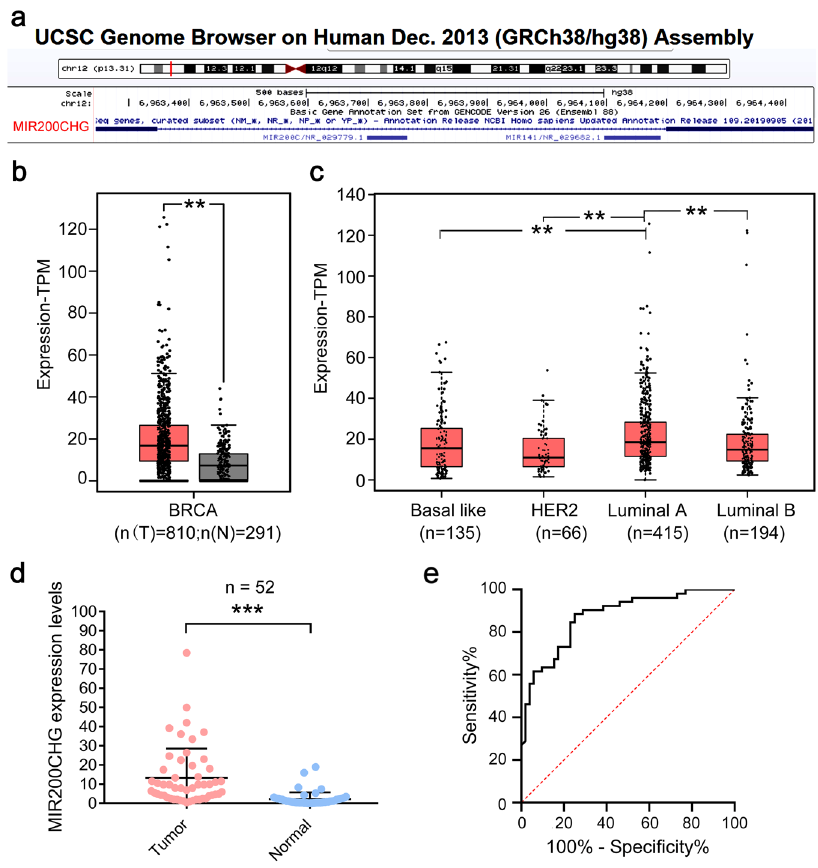
Fig. 1 MIR200CHG is upregulated in breast cancer tissues. a Gene structure of MIR200CHG. b , c The expression of MIR200CHG in breast cancer and its subtypes in The Cancer Genome Atlas was analyzed by GEPIA2. N, non-tumor tissue, gray. T, tumor tissue, red. ** P < 0.01. Boxplots represent medians (center line) and interquartile range (IQR; box), and whiskers represent the maximum and minimum values within 1.5 times the IQR from the edge of the box. d qRT-PCR was used to analyze the expression level of MIR200CHG in breast cancer tissues and adjacent non-tumor tissues, n = 52. GAPDH was used as an internal control. Dot plot of the individual data points, with a horizontal line at the arithmetic mean and error bars showing plus and minus one standard deviation. The data were analyzed by two-tailed unpaired T test. *** P < 0.001. e Receiver operating characteristic curve analysis based on the level of MIR200CHG in 52 analyzed breast cancer MIR200CHG increase the proliferation of MDA-MB-231 cells (Fig. 2e, f). Colony formation experiments con fi rm that compared with the control group, knockdown of MIR200CHG reduce the MCF7 cell colony formation rate to 8.62%, while overexpression of MIR200CHG increase the rate of MDA-MB-231 cell colony formation to 176.17% (Fig. 2g, Supplementary Fig. 2a). Flow cytometry analysis show that compared with the negative control group, the cell cycle distribution of MCF7-sh and MDA-231-exp does not change signi fi cantly (Fig. 2h, i, Supplementary Fig. 2b). Apoptosis analysis shows that knockdown of MIR200CHG increased the apoptosis rate in MCF7 cells, while overexpression of MIR200CHG does not signi fi cantly change the apoptosis rate in MDA-MB-231 cells (Fig. 2j, Supplementary Fig. 2c). Wound healing experiments show that the average open wound area of MCF7-sh cells (incubated for 20 h) is about 72.1%, and that of negative control cells is about 24.2%. The average open wound area of MDA-231-exp cells (incubated for 6 h) is about 44.2%, and that of the negative control cells is about 91.0% (Fig. 2k, l, Supplementary Fig. 2d). In the cell invasion experiments, the number of MCF7-sh cells passing through the Matrigel pores is 32.5% of the negative control group, while the number of MDA-231-exp cells reaches 365.8% (Fig. 2m, Supplementary Fig. 2e). Furthermore, on conducting cisplatin drug sensitivity experiments, knockdown of MIR200CHG signi fi cantly decreases the IC 50 of MCF7 cells from